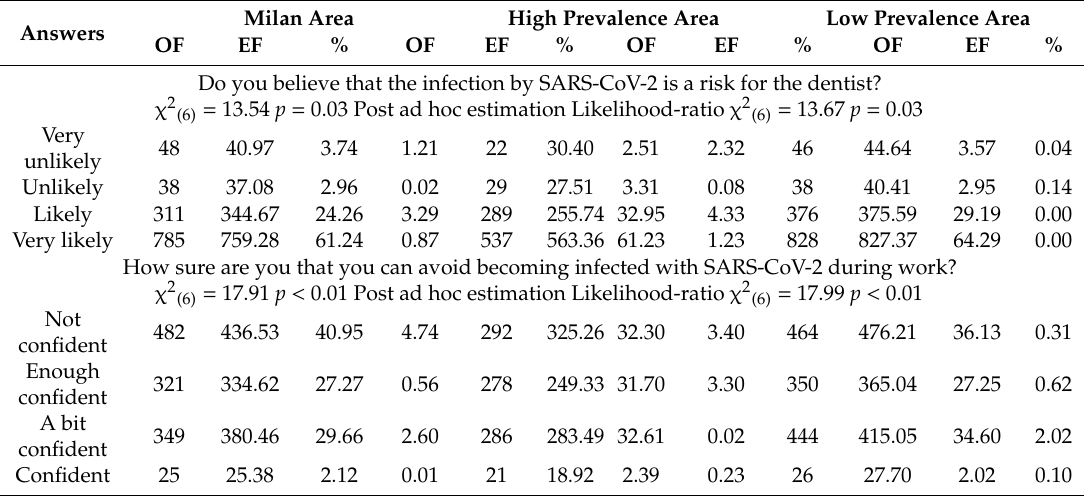
Table 9. Risk perception of COVID-19 stratified by areas with di ff erent prevalence of COVID-19. Percentages were calculated per